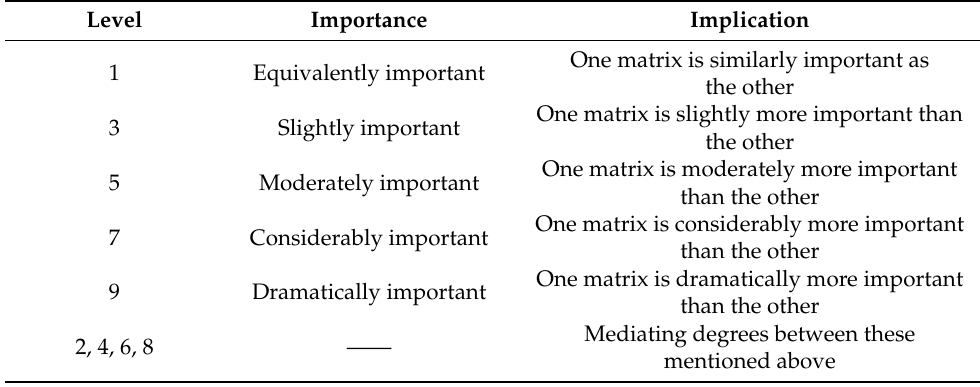
Table 6. The importance of levels 1–9 in the questionnaire.